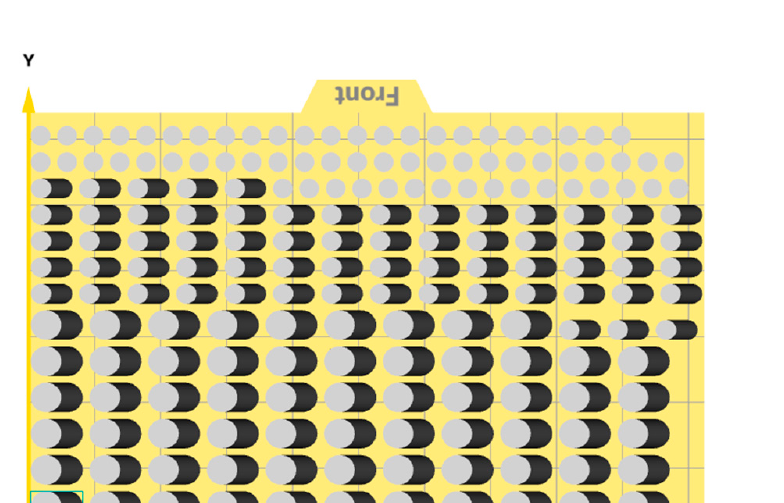
Table 2. Numbers of building platforms needed to manufacture approx. 1000 components of each cylinder